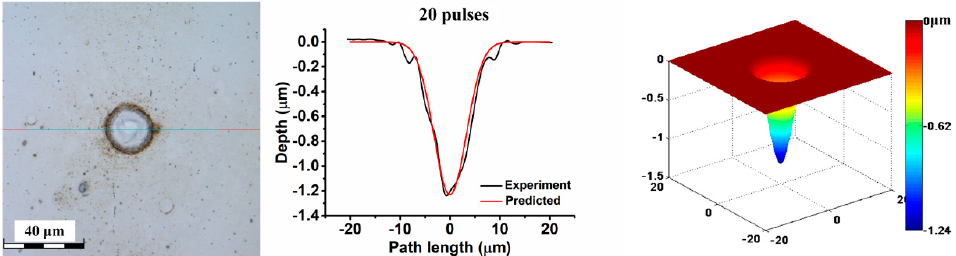
Figure 3. The comparison between experimental and predicted micro-crater for 20 pulses.